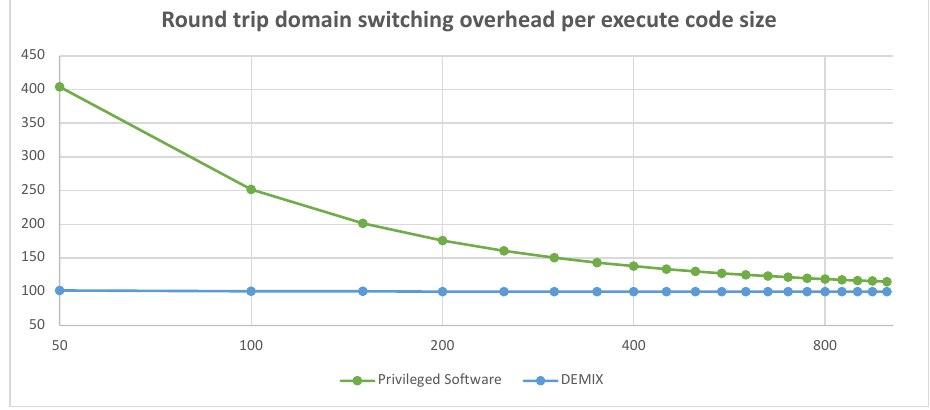
Figure 6. Roundtrip-switching overhead per code